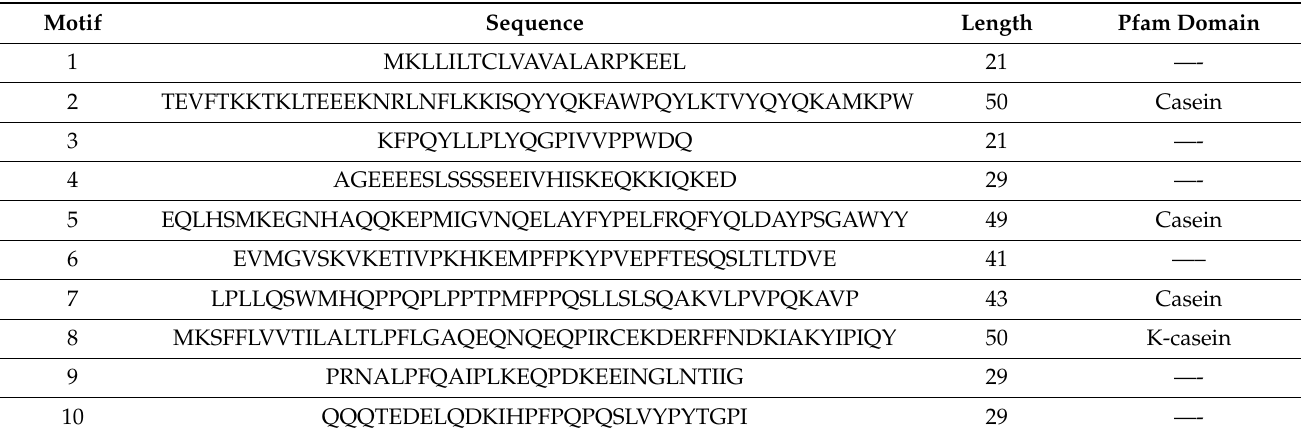
Table 1. In the casein protein gene family, ten distinct conserved motifs were identified (CSN1S1, CSN1S2, CSN2, and CSN3).